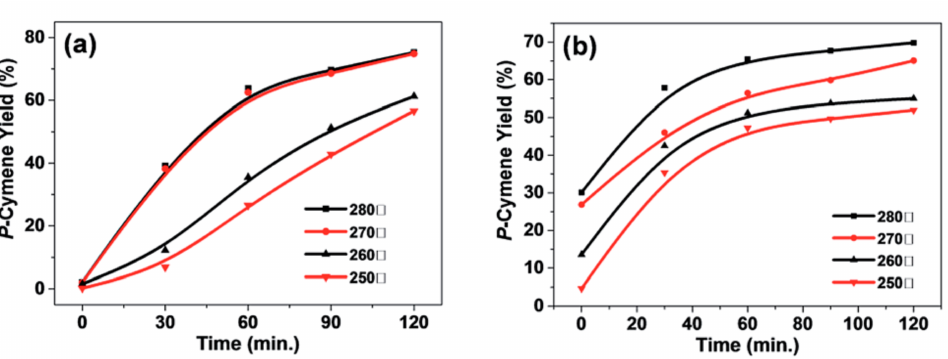
Figure 5. Conversion of limonene into p-cymene over the Pd/HZSM-5 catalyst as a function of time at 240, 260, 280, 300 ◦ C ( a ) in absence of added hydrogen and ( b ) under inert atmosphere. Reproduced with permission from Cui et al. [82]. Copyright (2016) Royal Chemical